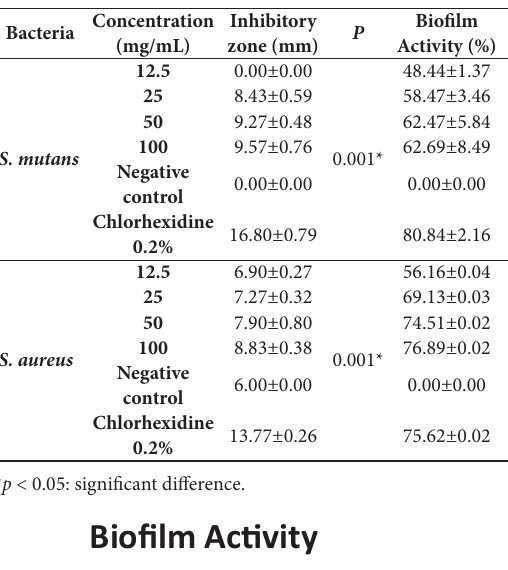
Table 1. Minimum inhibitory zones and biofilm activity assay of Medan BPCE against S . mutans and S. aureus .